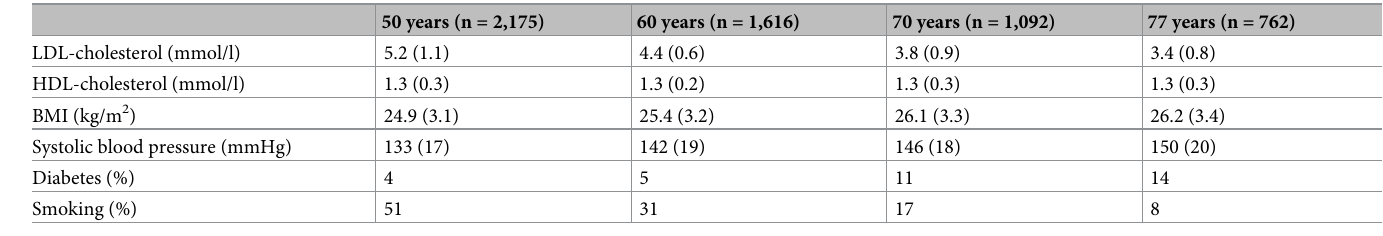
Table 1. Basic characteristics (mean (SD)) at the four examination cycles in the ULSAM-cohort for participants with full information on physical